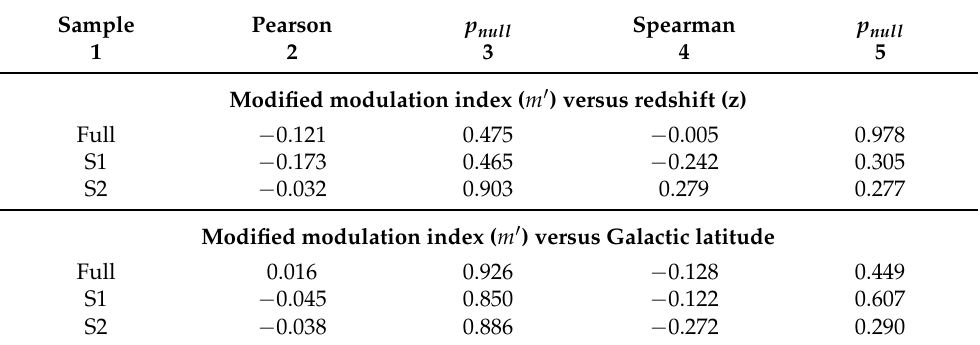
Table 3. Results of correlation analysis for modified modulation index ( m (cid:48) ), redshift ( z ) and Galac- Table 1; S2—target sources in Table 2). Column 2 and 3: Pearson correlation coefficient and the probability of no correlation. Column 4 and 5: Spearman correlation coefficient and the probability of no correlation. Sample Pearson p null Spearman p null 1 2 3 4 5 Modified modulation index ( m (cid:48) ) versus redshift (z) Full 0.121 0.475 − S1 0.173 0.465 − S2 0.032 0.903 0.279 0.277 − Modified modulation index ( m (cid:48) ) versus Galactic latitude Full 0.016